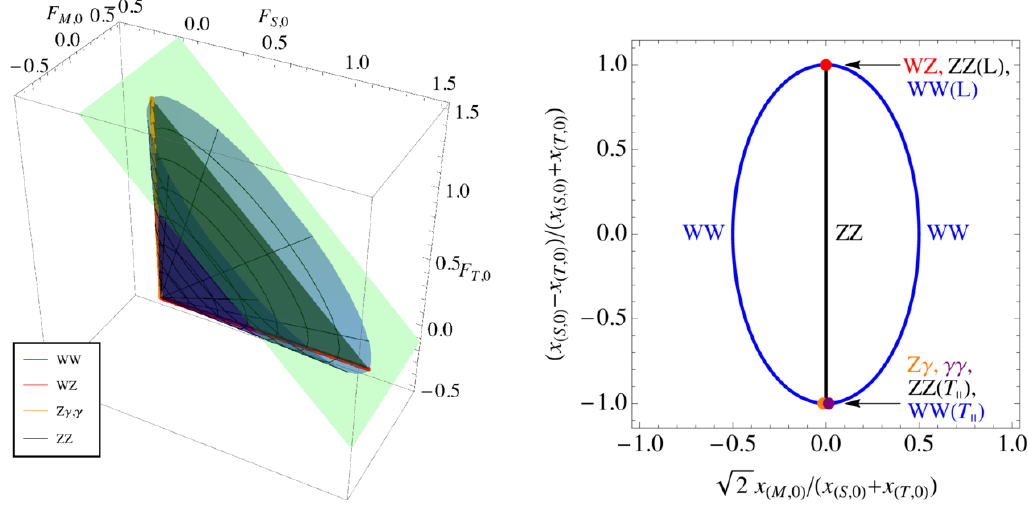
Figure 8 . Similar to (cid:12)gure 6. Left: the vectors ~x i ( ~a;~b ) intersect the plane x p x = 2, leaving a set of intersection points. Right: the intersection points ~P i ( ~a;~b ) = ( T; 0) (cid:16) p 2 x (cid:17) i; ( M; 0) ; x i; ( S; 0) (cid:0) x i; ( T; 0) on the plane form a ellipse. Colors represent di(cid:11)erent scattering x i; ( S; 0) + x i; ( T; 0) x i; ( S; 0) + x i; ( T; 0) channels. The T and L in the brackets denote the corresponding polarisation con(cid:12)guration in the k WW and ZZ channels that give the top and bottom points, see table 1 in section